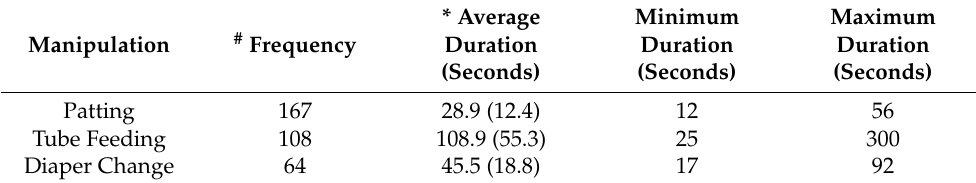
Table 3. Frequency and duration of manipulations recorded.